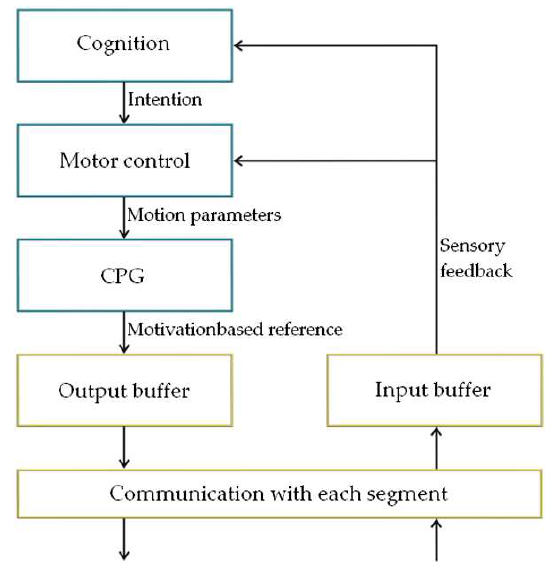
Figure 7: Control scheme developed for the brain of the snake